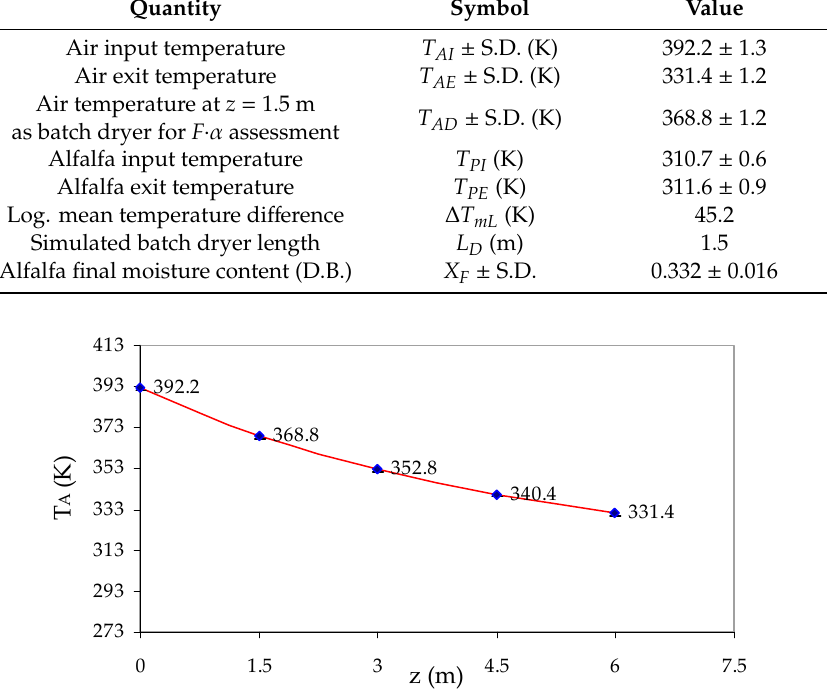
Figure 6. Experimental curve of the air temperature decay, T A , vs. the horizontal distance, z , from the input of the dryer.